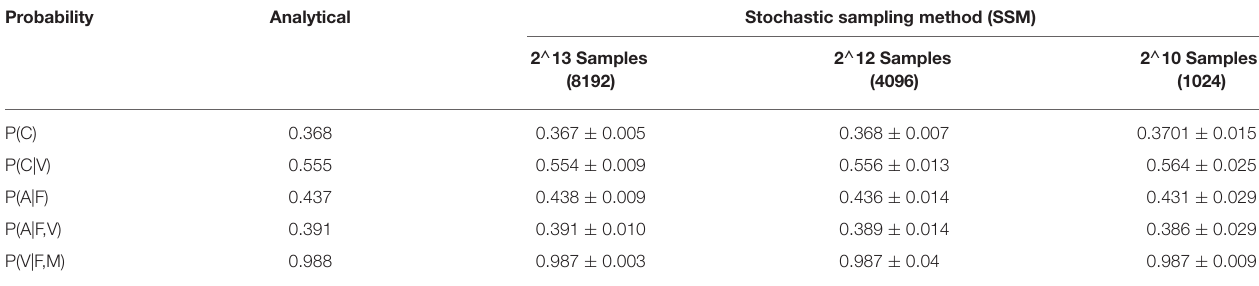
TABLE 1 | Comparison of the probabilities of the BIND framework (Figure 3), calculated using the SSM for various samples and the analytical methods. Probability